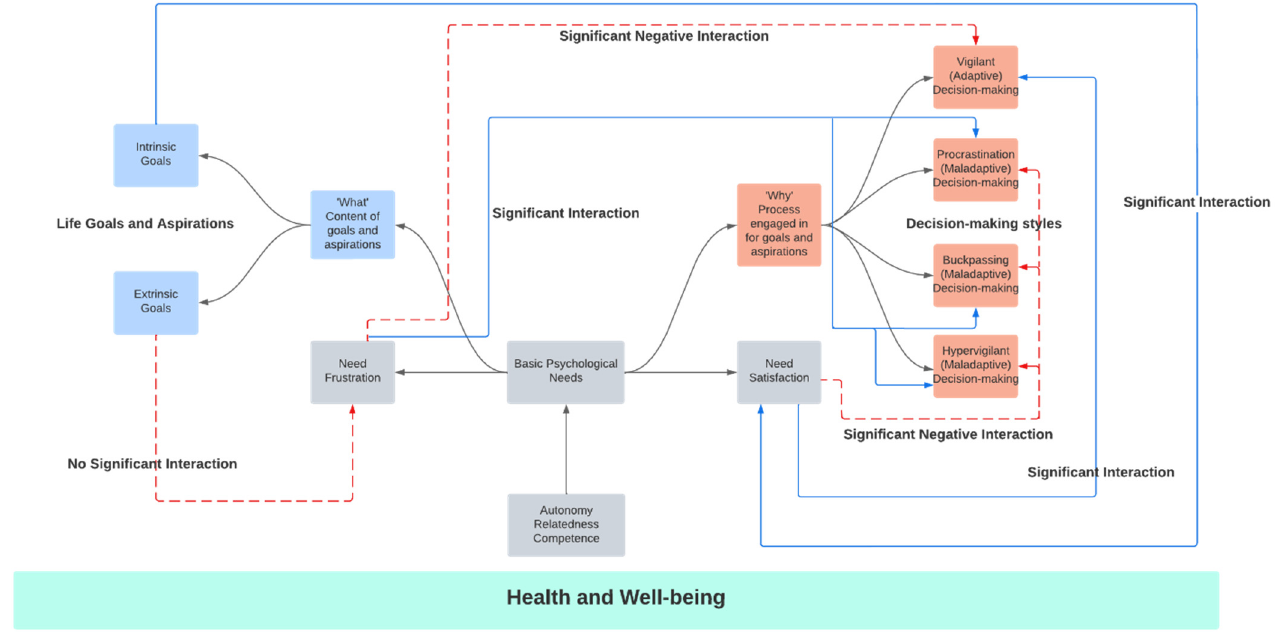
Figure 1. A diagrammatical representation of the interaction between basic psychological needs, decision-making and life goals of emerging adults in South Africa. All significant positive associations are indicated in the solid, blue arrow, while significant negative associations are indicated in a dash, red arrow.